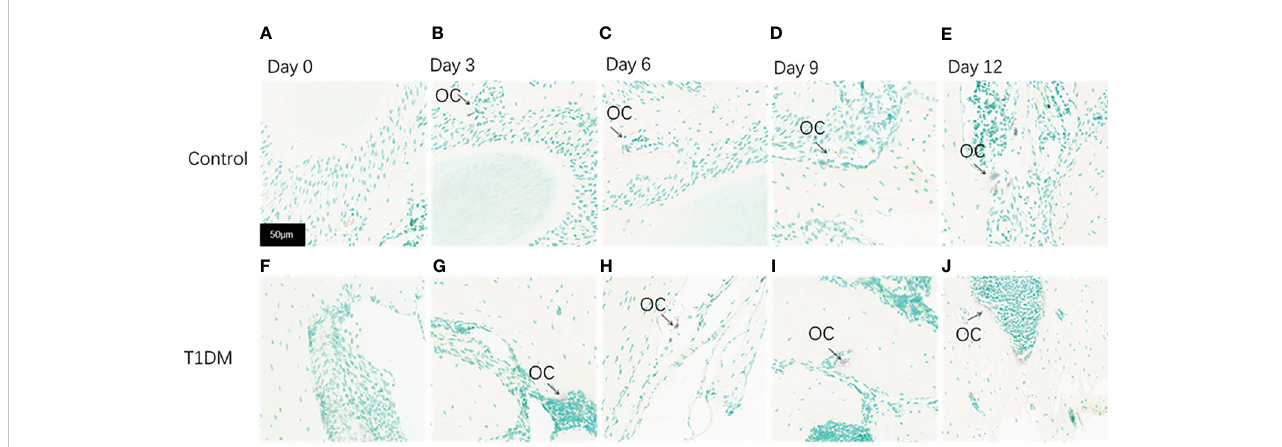
FIGURE 6 Tartrate-resistant acid phosphatase staining(TRAP staining) of the periodontium of mandibular molars in both groups on days 0, 3, 6, 9, and 12 of the experiment. (A – E) are from control mice, and (F – J) are from T1DM mice. 0 to 12 days after the extraction of the surgery, the number of osteoclasts increased gradually in both groups, however, the number of osteoclasts in the T1DM group was higher than that in the control group. The arrows indicate the site of positive osteoclast staining. OC, osteoclast